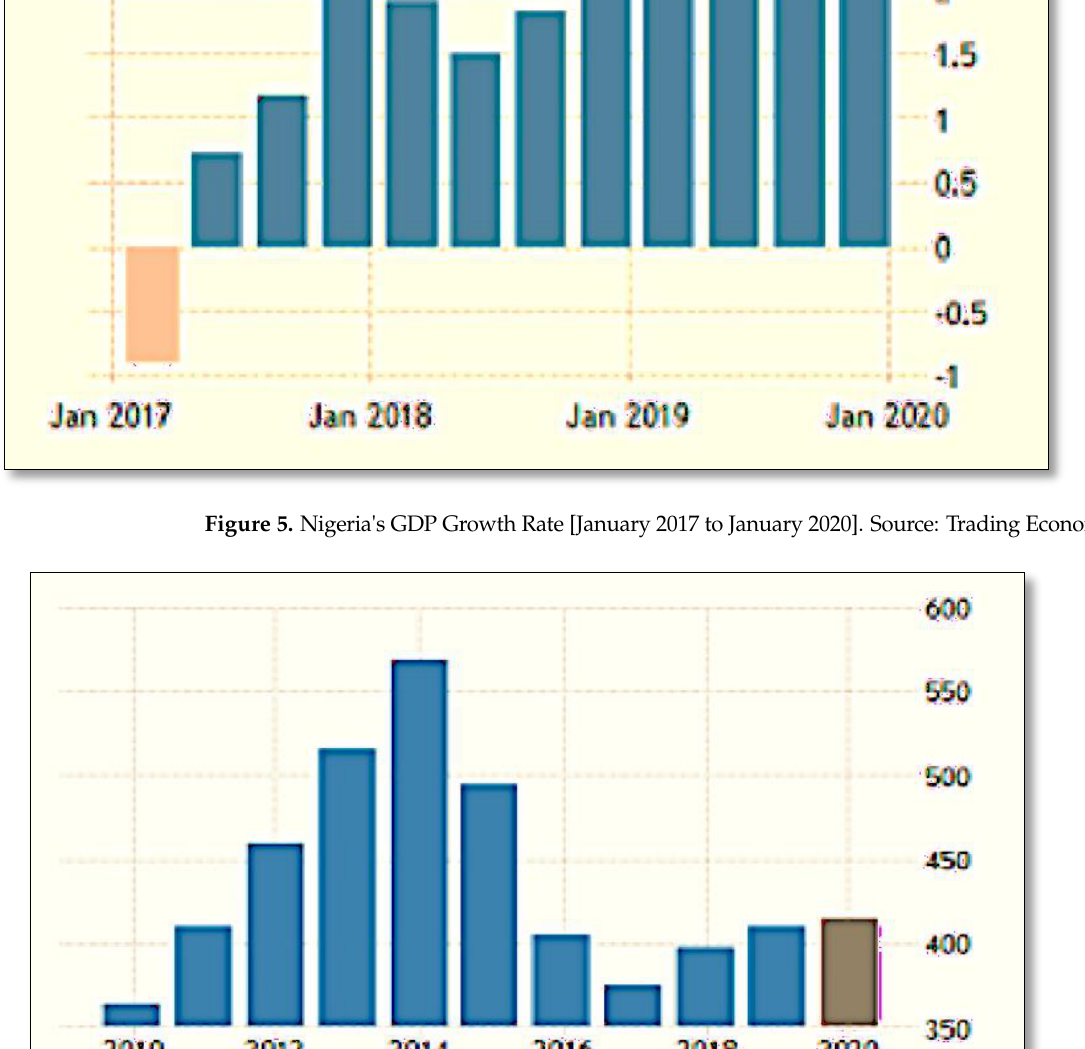
Figure 6. N igeria’s GDP Per Capita [2010– 2020] [US dollars] . Figure 6. Nigeria’s GDP Per Capita [2010–2020] [US